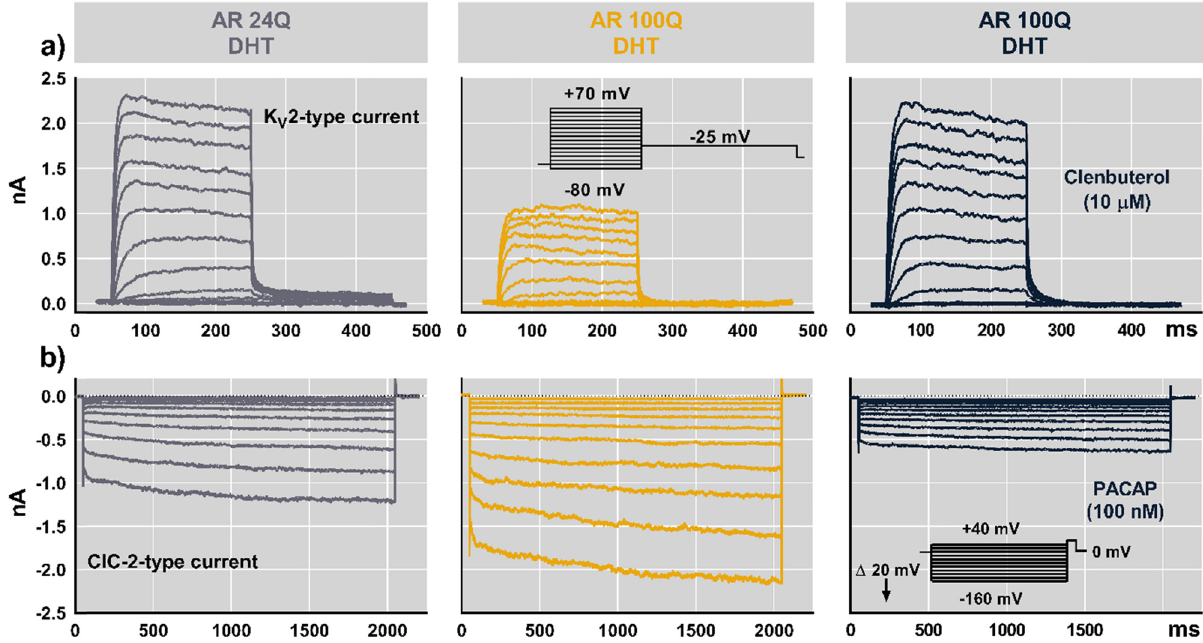
Figure 1: Membrane currents isolated in physiological ( AR24Q ) and pathological ( AR100Q ) conditions. The pathophysiological mechanisms associated with SBMA disrupt the ion channel activity in SBMA MN - 1 cells exposed to DHT. The treatment with clenbuterol ( a ) or PACAP ( b ) reverts the dysregulation of K - type or ClC - 2 - like ionic currents, respectively. The voltage stimulation protocol is depicted for V 2 potassium as well as chloride currents ( modi fi ed and adapted from refs. [ 19,20 ])